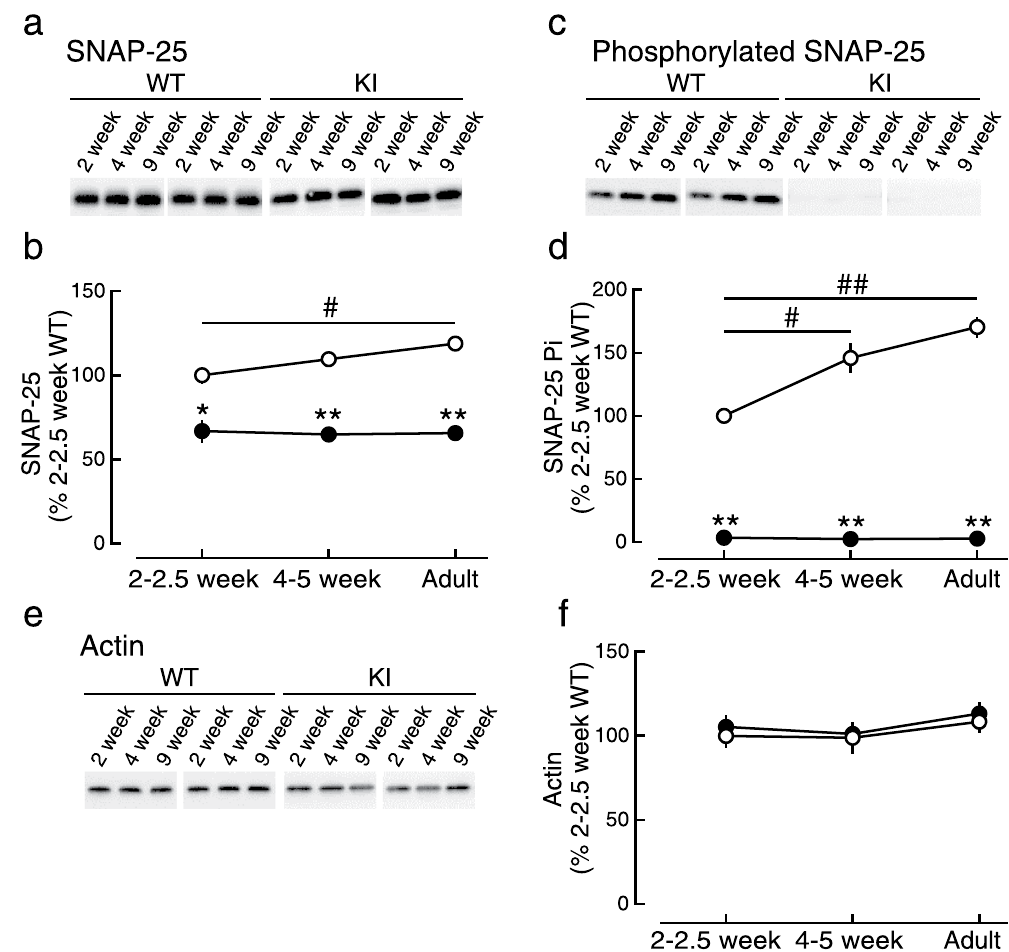
Figure 3. Developmental changes in SNAP-25 expression and phosphorylation in the hippocampus. ( a , b ) Expression levels of SNAP-25 in the hippocampus were measured by Western blot analyses. The density of the bands was normalized to that of 2–2.5-week-old WT mice. ( c , d ) Phosphorylation levels of SNAP-25 at the residue serine-187 in the hippocampus were measured by Western blot analyses. The density of the bands was normalized to that of 2–2.5-week-old WT mice. ( e , f ) Expression levels of actin in the hippocampus were measured as a control. * and # indicate significant differences between the genotypes and between the ages,